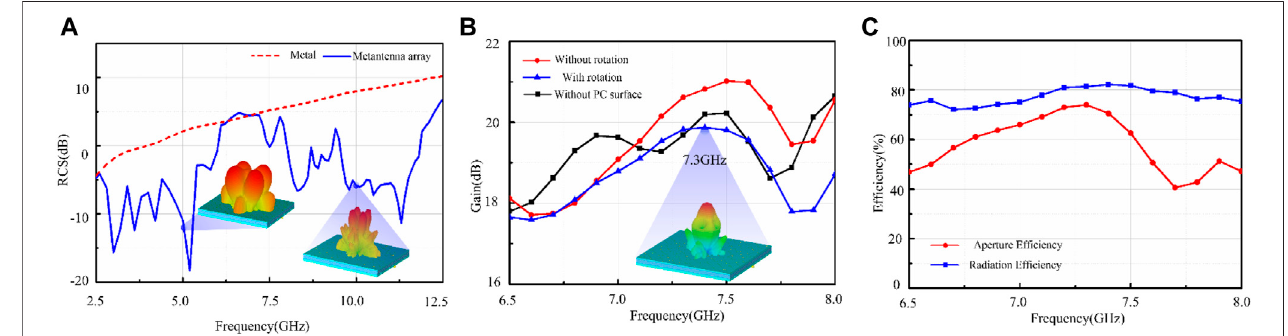
FIGURE 6 | (A) Simulated RCS under the x -polarized wave and the illustrations are 3-D far- fi eld scattering pattern at 5.0 and 10.0 GHz. (B) Simulated peak gain with and without rotating the PC unit. The illustration is radiation pattern at 7.3 GHz. (C) Radiation ef fi ciency and aperture ef fi ciency of the